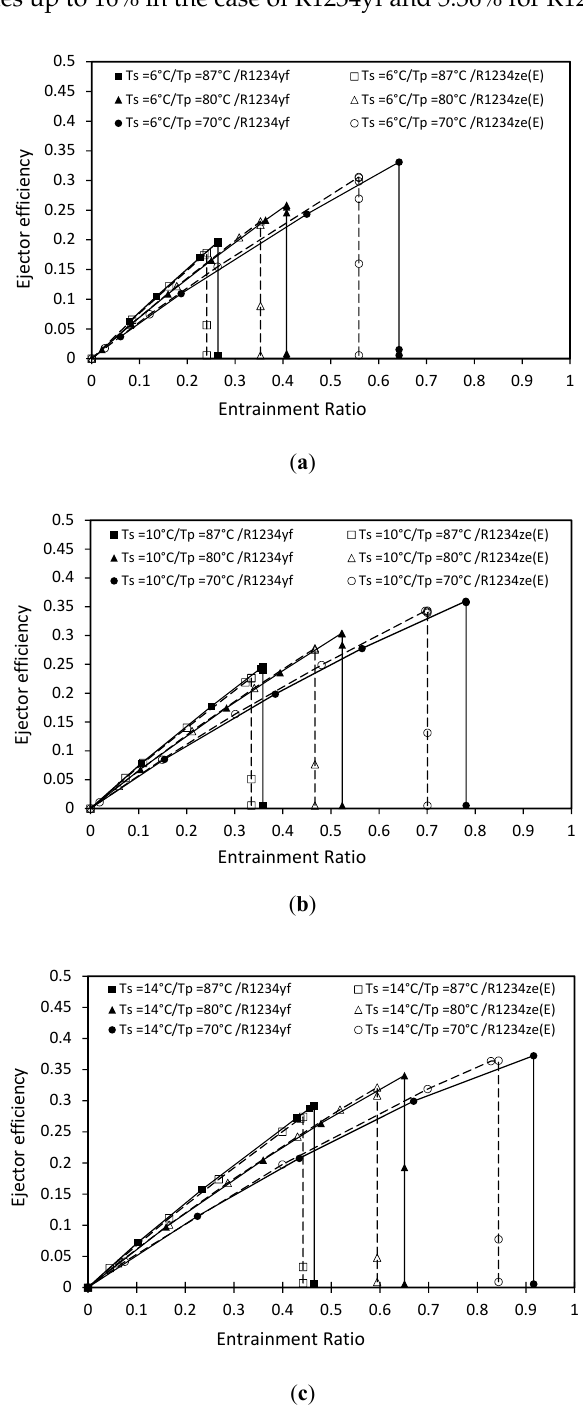
Figure 12. Ejector efficiency vs the mass entrainment ratio for various working conditions based on CFD results. (a) T s = 6°C. (b) T s =10°C. (c) T s = 14°C.